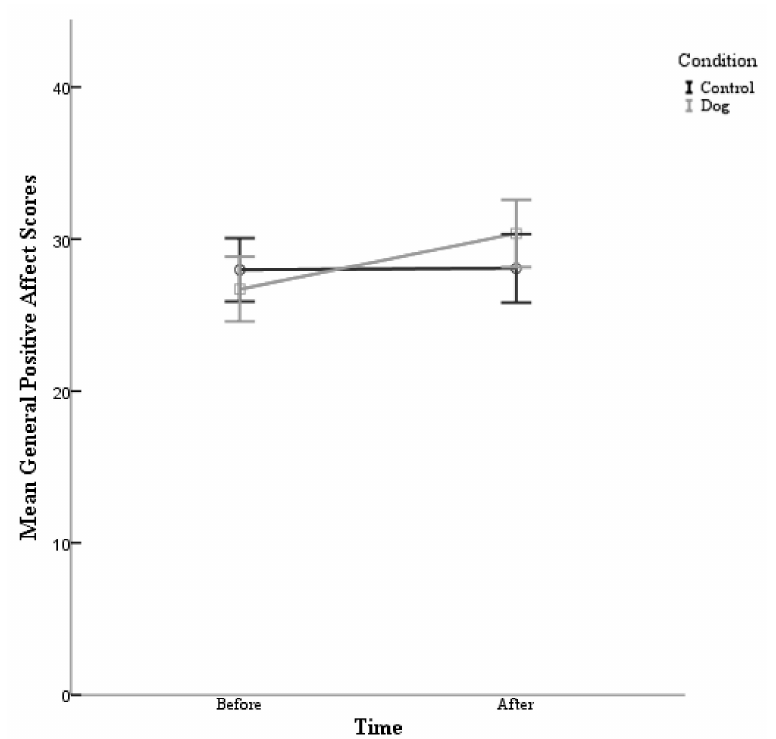
Figure 4. The mean for general positive a ff ect is plotted for the participants in the control condition and the participants in the experimental (dog) condition before their interaction and after their interaction with 95%-confidence-interval error bars.